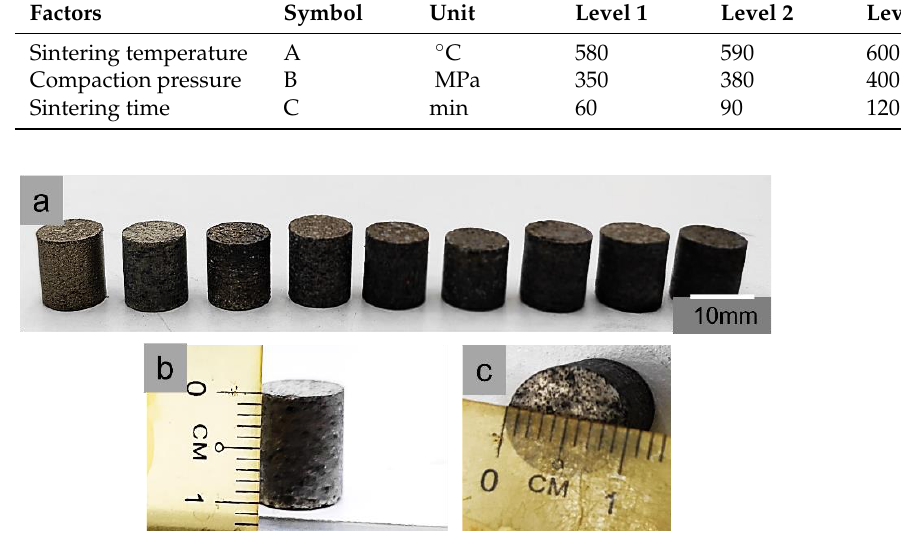
Figure 2. Sintered samples of, ( a ) 10 mm × 10 mm (1 cm × 1 cm) size, ( b ) 1 cm height, ( c ) 1 cm di- ameter.